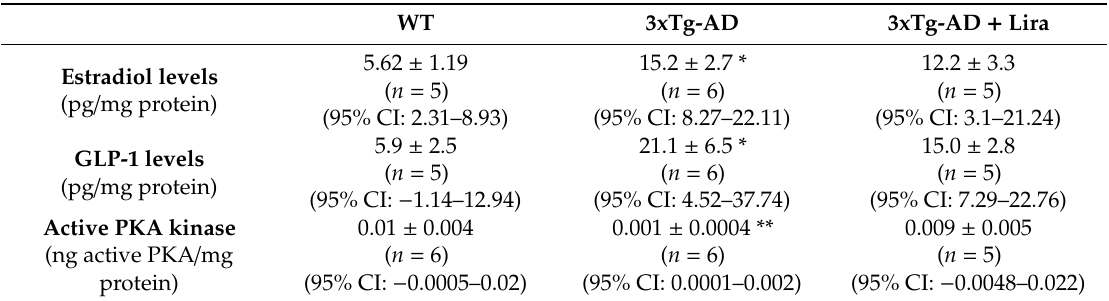
Table 2. E ff ect of liraglutide administration on brain cortical hormones’ levels and signaling in female mice with early AD-like pathology.